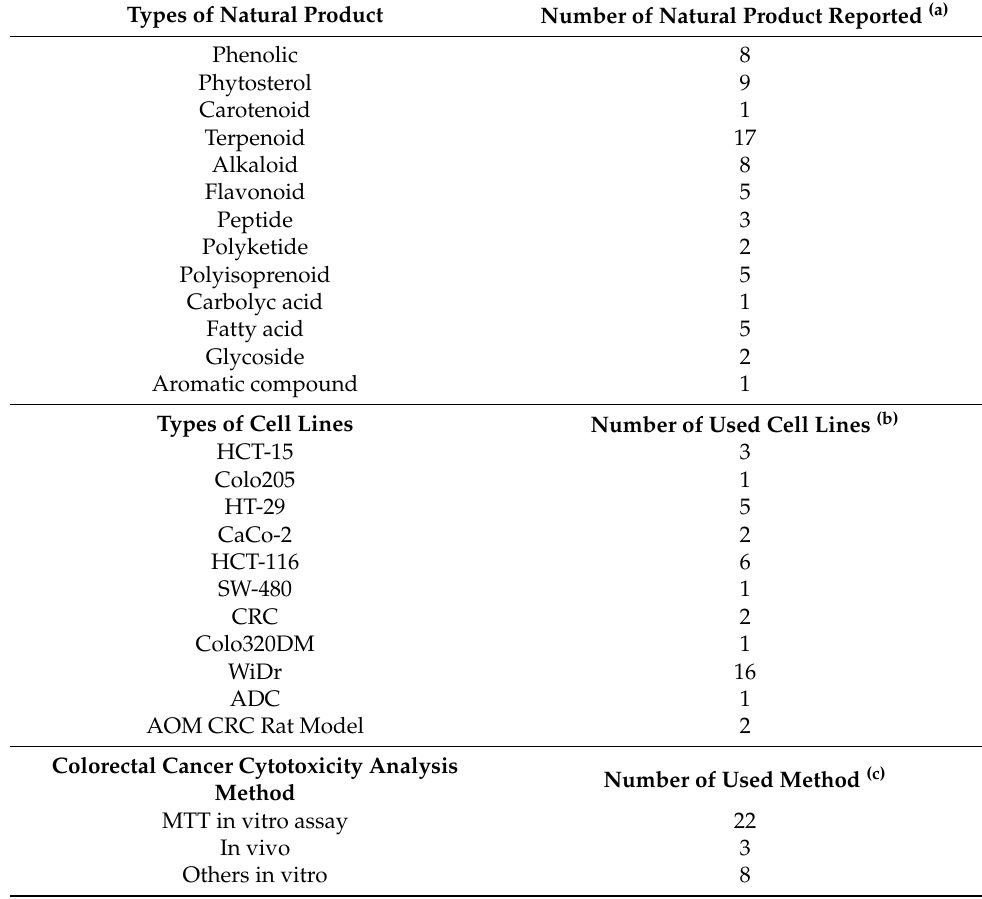
Table 5. Systematic review results summarized from 38 publications: ( a ) types of natural product; ( b ) the number of used cell lines; ( c ) colorectal cancer cytotoxicity analysis